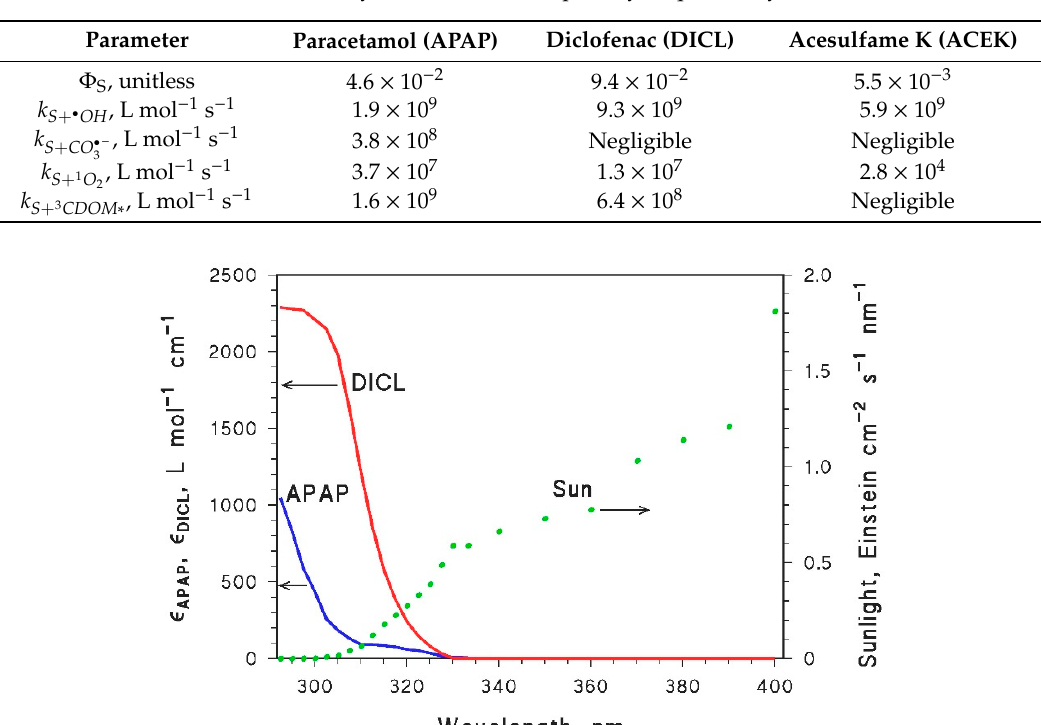
Figure 1. Left y -axis: Absorption spectra (molar absorption coefficients) of paracetamol (APAP) and diclofenac (DICL) [23,24]. Right y -axis: Spectral photon flux density of sunlight, incident on the water surface. In mid-latitude conditions, this value of spectral photon flux density can be observed in July in mid-morning or mid-afternoon [27,39]. Note that ACEK does not absorb radiation at λ > 280 nm [25], thus it does not undergo direct photolysis under sunlight irradiation. Table 2. Comparison between field data and model predictions for the phototransformation kinetics of paracetamol (APAP), diclofenac (DICL), and acesulfame K (ACEK).